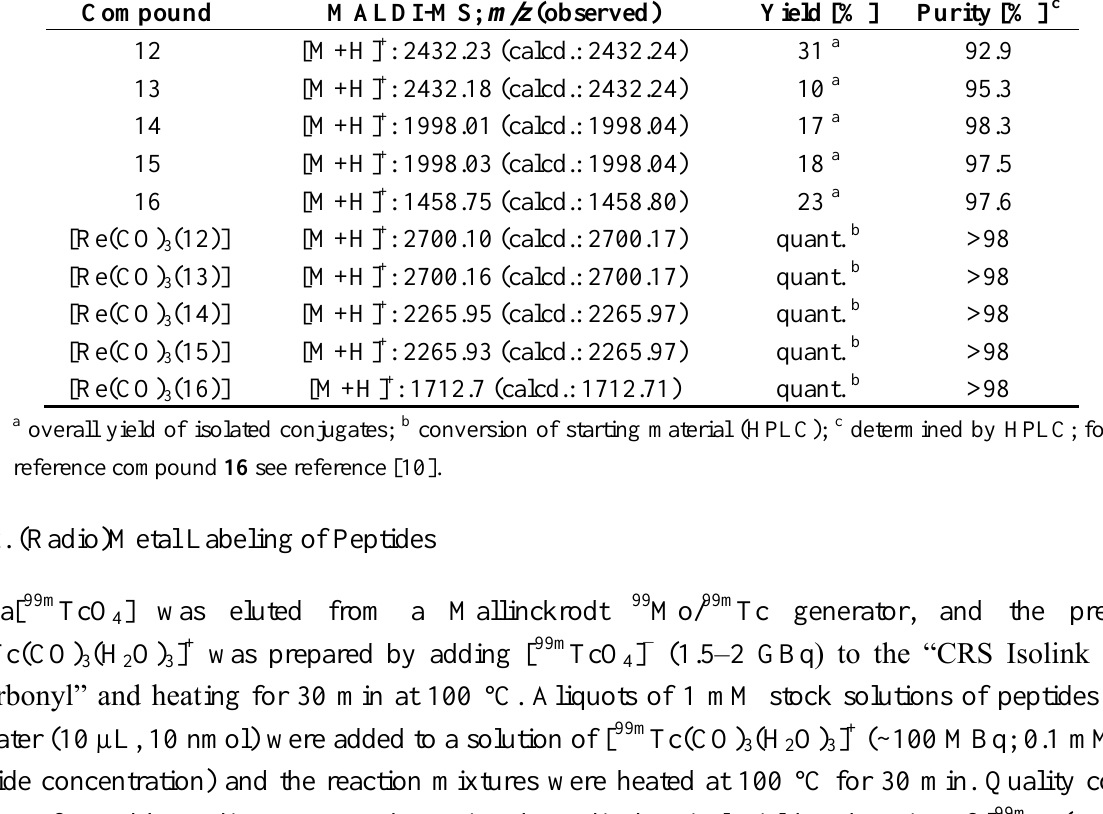
Table 1. Analytical data and yields of synthesized peptides and nat Re-complexes thereof. Compound MALDI-MS; m/z (observed)